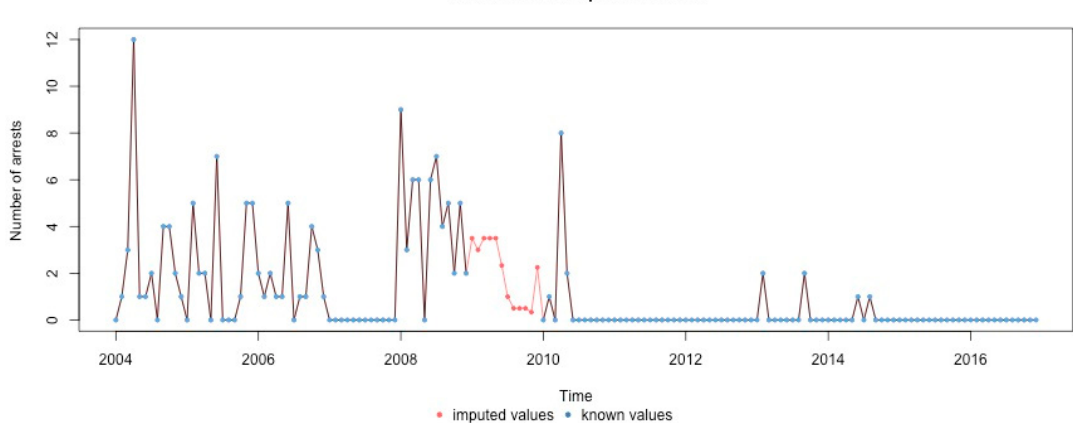
Figure A21. Heroin organized crime arrests 2004–2016 in the Czech Republic – imputed missing values.